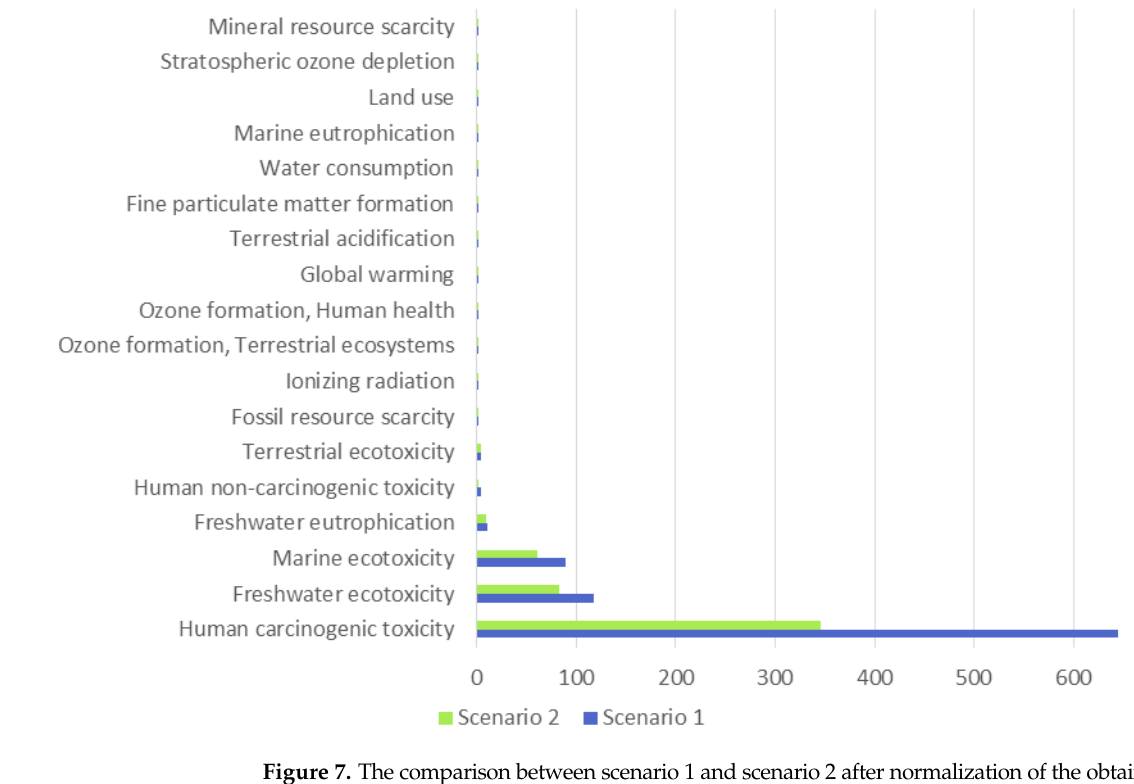
Figure 7. The comparison between scenario 1 and scenario 2 after normalization of the obtained results.